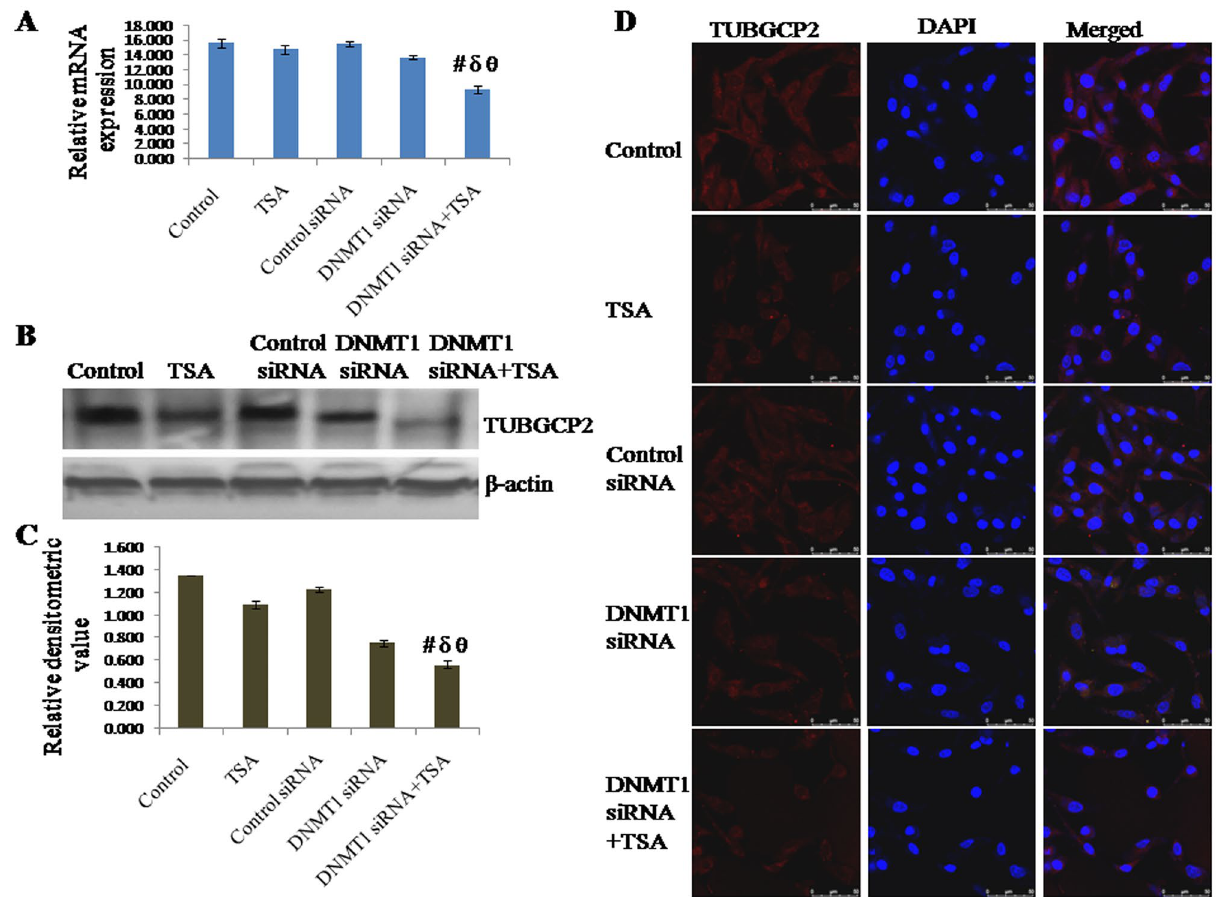
Figure 3. Expression of TUBGCP2 analyzed by ( A ) qRT-PCR using GAPDH as internal control and expressed in terms of relative mRNA expression, ( B , C ) Western blotting using β-actin as internal control and expressed in terms of relative densitometric value, ( D ) immunofluorescent staining and confocal microscopy to observe cellular localization of TUBGCP2. The representative blots of replicates were presented here. The full-length original images (cropped) of representative blots were presented in the supplementary Fig. S4 of Supplementary information file. Data was represented as mean ± SEM., n = 3, p < 0.05. #, δ and θ represent; compared to control group, TSA treated group and DNMT1 siRNA transfected group